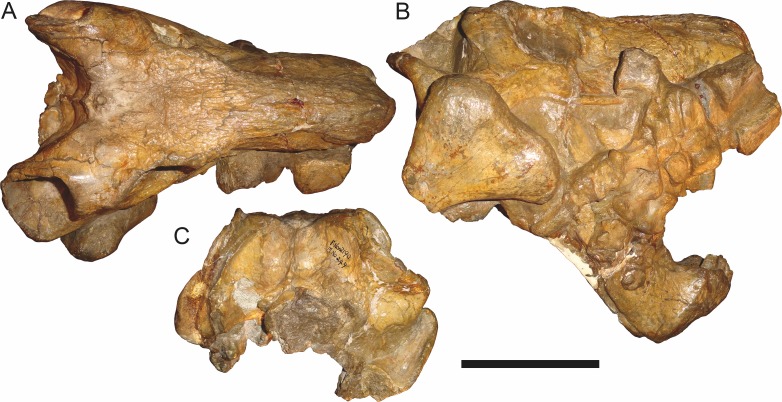
Referred specimen (BP/1/2190) of Dinogorgon rubidgei
Broom, 1936 in (A) dorsal, (B) right lateral, and (C) occipital views.Holotype of Prorubidgea robusta
Brink & Kitching, 1953. Scale bar equals 10 cm.